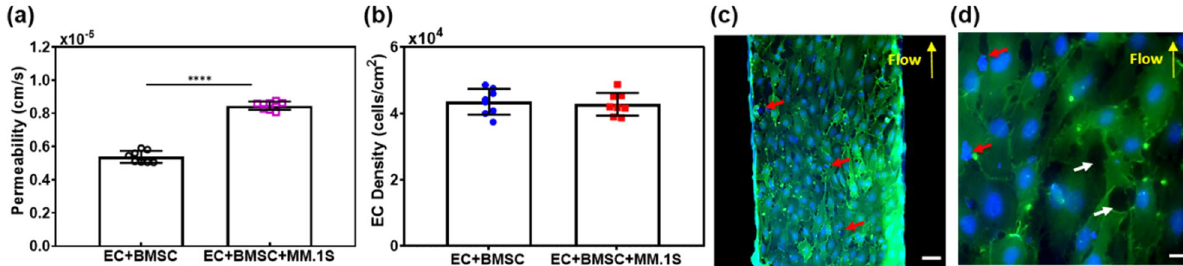
Figure 7. Effects of CXCL12-meditated egression of MM.1S cancer cells on dextran permeability, EC viability, and EC junction pore density. ( a ) P D of 70 kDa FITC-dextran between ECs and BMSCs cultured for 26 h followed by the addition of CXCL12 for 4 h (EC + BMSC) versus ECs, BMSCs, and MM.1S cells cultured for 26 h and then CXCL12 added for 4 h (EC + BMSC + MM.1S). The mean ± SD of six samples per condition were analyzed. **** P < 0.0001 determined by t-test. ( b ) Viability of ECs measured for “EC + BMSC” versus “EC + BMSC + MM.1S” (8 images analyzed per condition, mean ± SD). ( c ) and ( d ) Confocal fluorescence images of the endothelium, showing MM.1S located at EC junction pores in the presence of CXCL12. The white arrows indicate junction pores, the red arrows indicate MM.1S cells, and yellow arrows indicate flow direction. Scale bars: 100 μm in ( c ) and 10 μm in ( d Figure 6b shows the migration of MM.1S cells from the stroma chamber to the sinusoid chamber as evident from the higher density of Hoechst-stained MM.1S cells toward the endothelium. In Fig. 6d,e, the cross-sectional confocal fluorescence views imaged without and with adding CXCL12, respectively, are compared. MM.1S cells were evenly distributed in the stroma chamber in the absence of CXCL12 (Fig. 6d) whereas more MM.1S cells were observed at the stroma/sinusoid interface with CXCL12 (Fig. 6e). In contrast, the spatial distribution of BMSCs (red cells) was not affected by adding CXCL12. Figure 6g shows the migration data quantified by count- ing the number of MM.1S cells as a function of z-axis positions specified in Fig. 6b. The cell density of MM.1S cells decreased in the axial direction of the stroma chamber toward the sinusoid chamber, as expected from their migration toward the high concentration of CXCL12 in the sinusoid chamber. In contrast, the density of BMSCs did not change along the axial direction with or without CXCL12. The presence of migrating MM.1S cells (indicated by the red arrows in Fig. 6c) in the endothelium was observed during the z-stack confocal fluorescence analysis. From Fig. 6c, the average pore size at junction gaps was measured to be 2 to 20 µm. Figure 6f shows a representative SEM image of the endothelium with small junc- tion gaps as well as the presence of MM.1S cells identified by their round morphology. Furthermore, time-lapse imaging confirmed the CXCL12-induced migration of MM.1S cells toward the endothelium (Supplementary Vid- eos 2 through 6). Fig. S6 shows BMSCs and MM.1S cultured in the stroma chamber at 4 h after adding CXCL12 in the sinusoid chamber. No close contacts between MM.1S cells and BMSCs were detected. Taken together, these results suggested that MM.1S cells migrated through the endothelium in response to CXCL12 while BMSCs did not. We further evaluated the CXCL12 production by BMSCs and ECs by ELISA. As detailed in Supplementary Information 5, BMSCs and ECs produced very low levels of CXCL12 (below 100 pg/mL), supporting that: (1) MM.1S cells did not migrate to BMSCs and ECs via CXCL12/CXCR4 axis and (2) the migration of MM.1S cells was induced by the addition of CXCL12 in the sinusoid chamber. The effects of CXCL12-mediated MM.1S cell migration on the barrier function of ECs were evaluated by measuring P D and characterizing the morphological features of these cells. As described in the previous section, CXCL12 was introduced for 4 h in the sinusoid chamber after BMSCs. Figure 7a shows that P D significantly increased from 5.8 ± 0.2 × 10 –6 to 9.3 ± 0.1 × 10 –6 cm/s when MM.1S cells were present and their migration was induced. As indicated by the red arrows in Fig. 7c,d, the presence of MM.1S cells was observed throughout the endothelium layer, confirming migration. As detailed in the Methods section and shown in Fig. 6b, we pre- labeled ECs with CMFDA (green), MM.1S cells with Hoechst (blue), and BMSCs with CMTPX (red). For the confocal images in Fig. 7c,d, the cells were further fixed and stained with CD31 (green) and DAPI (blue). In Fig. 7d, round cells stained with blue only (both Hoechst and DAPI) were identified as transmigrated MM.1S cells. Elongated green cells (CMFDA) with stronger green intensity at cell junctions (CD31) and blue nuclei (DAPI) were identified as ECs. As indicated by the white arrows in Fig. 7d, junction gaps of 2 to 20 μm formed between ECs. These gaps were substantially larger than those of 1.5 to 10 μm formed in the absence of MM.1S cells (Fig. 5c). However, the density of ECs was not significantly influenced by the presence and migration of MM.1S cells (Fig. 7b), sug- gesting that the viability of ECs was not compromised by MM.1S migration. These results suggested that the migration of MM.1S cells was accompanied by openings in the EC junction pores and thus an increase in the P D of dextran through the endothelium layer without affecting the viability of ECs.